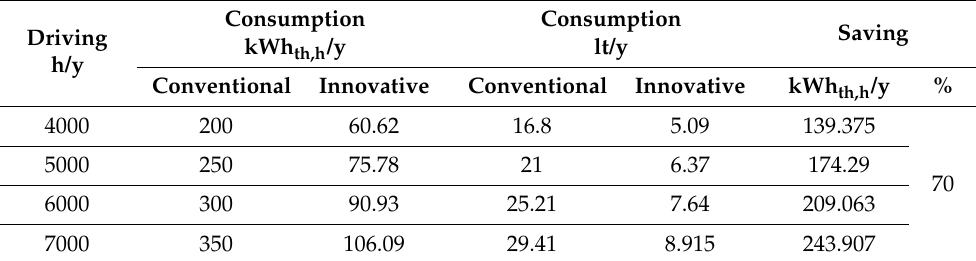
Table 2. Annual thermal energy consumption of the conventional and the innovative industrial product, under alternative scenarios of vehicles’ operation: high (7000 h/y), medium (6000 and 5000 h/y) and low (4000 h/y) annual driving hours.